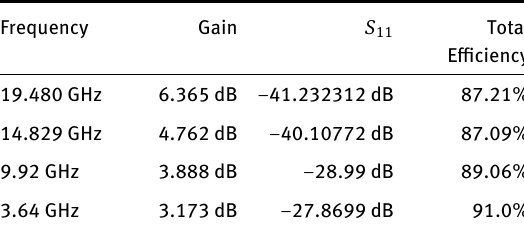
Table 2: Designed Parameters.